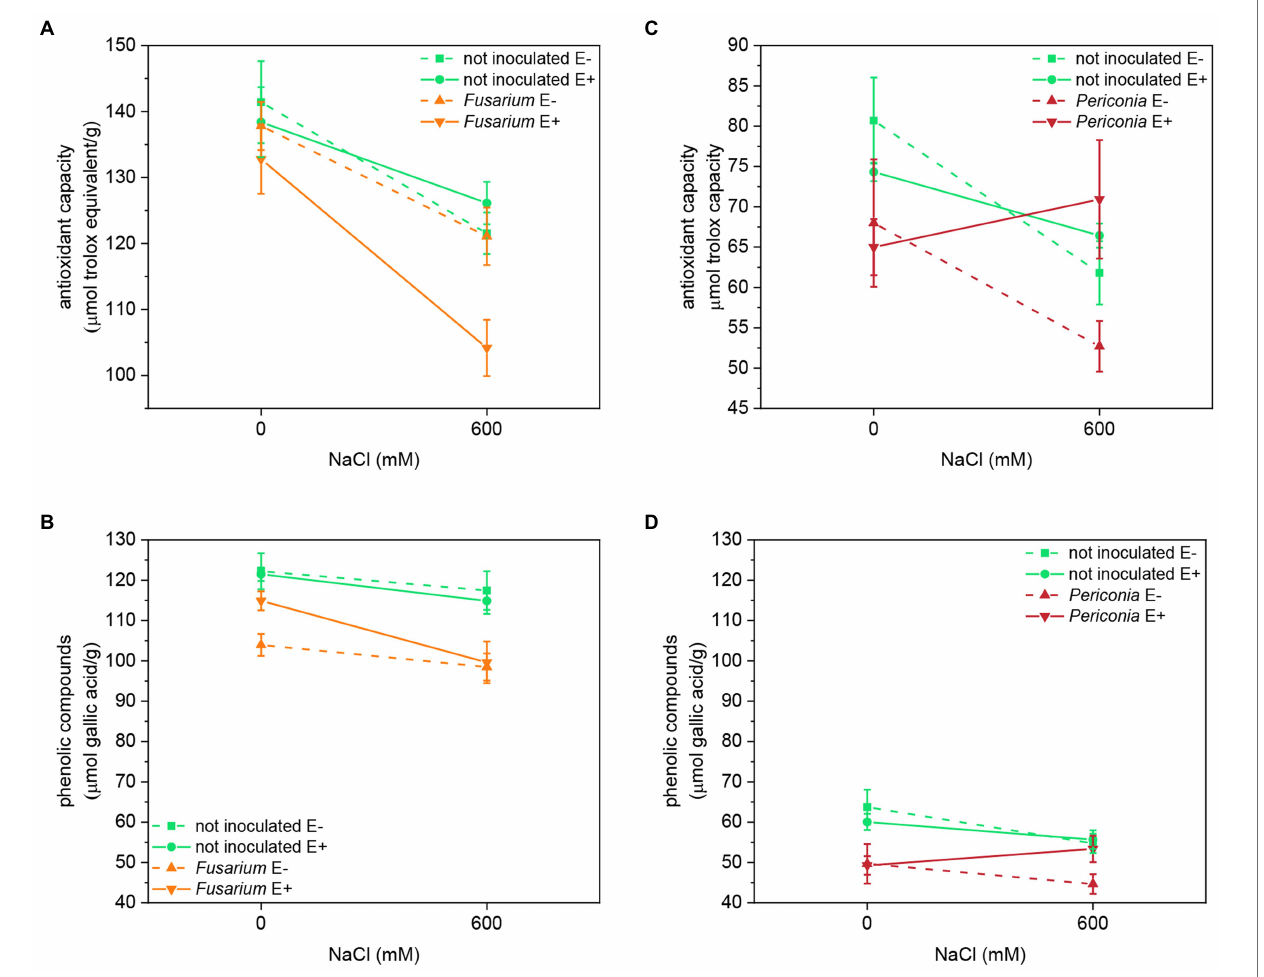
FIGURE 5 | Antioxidant capacity and phenolic compounds content in two FRP lines, EB15 (A,B) and TH12 (C,D) . Each line was composed by clones symbiotic with E. festucae (E + ) or Epichloë free (E – ). Plants of each line were inoculated with F. oxysporum T48 (orange), P. macrospinosa T131 (dark red), or uninoculated (green), and subjected to two different salinity treatments (0 and 600 mM